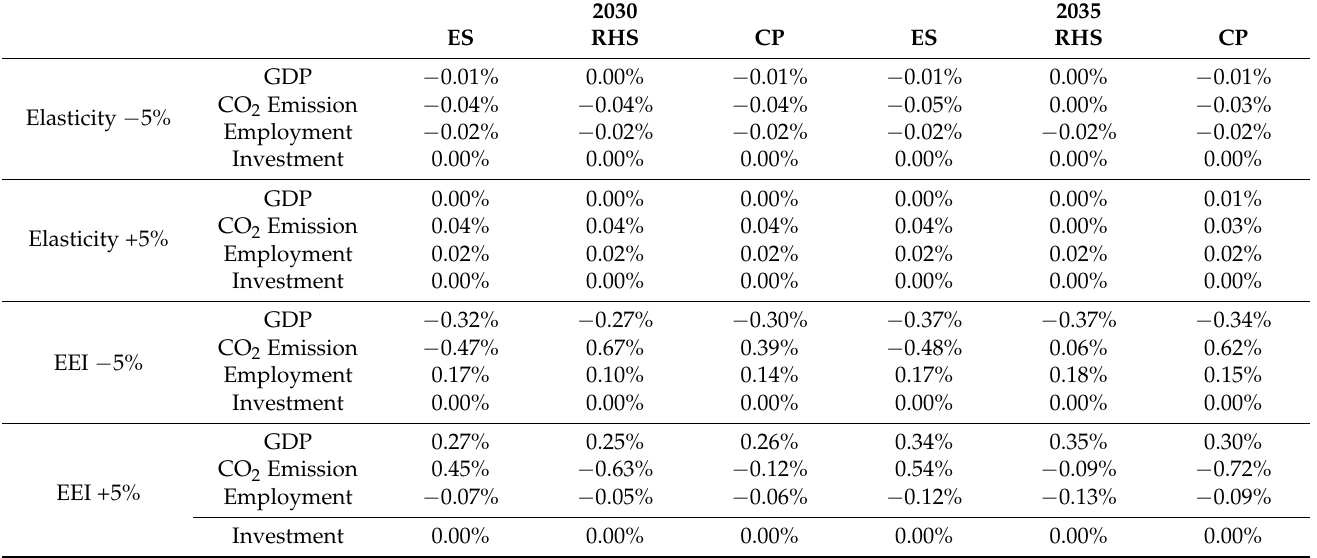
Table 6. Sensitivity